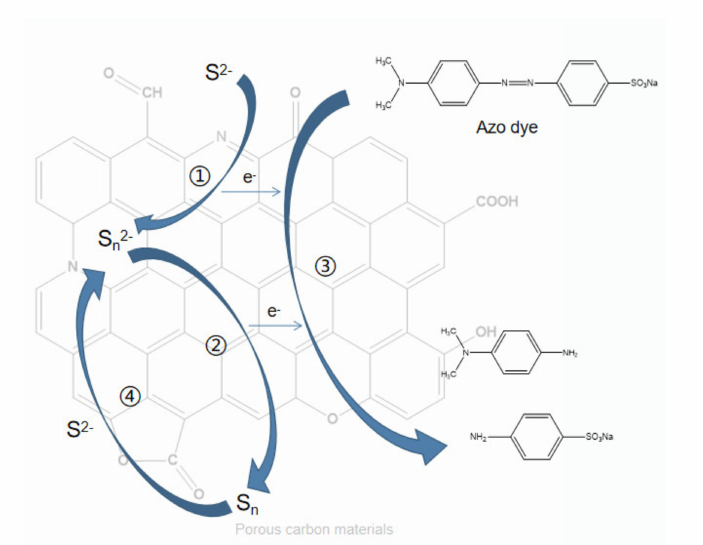
Scheme 1. Degradation of azo dyes by sulfides under the catalytic action of carbon materials, including